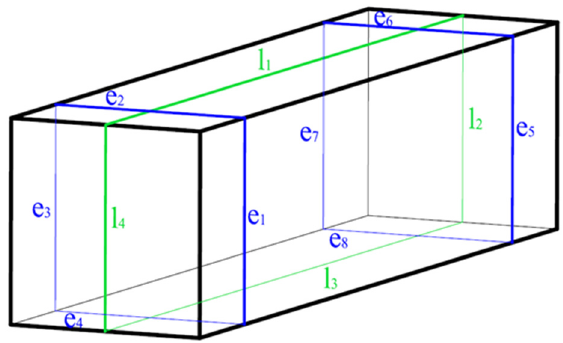
Figure 3. Measured points of samples in dimensional stability test (l corresponds to longitudinal dimensions, e corresponds to transversal dimensions).